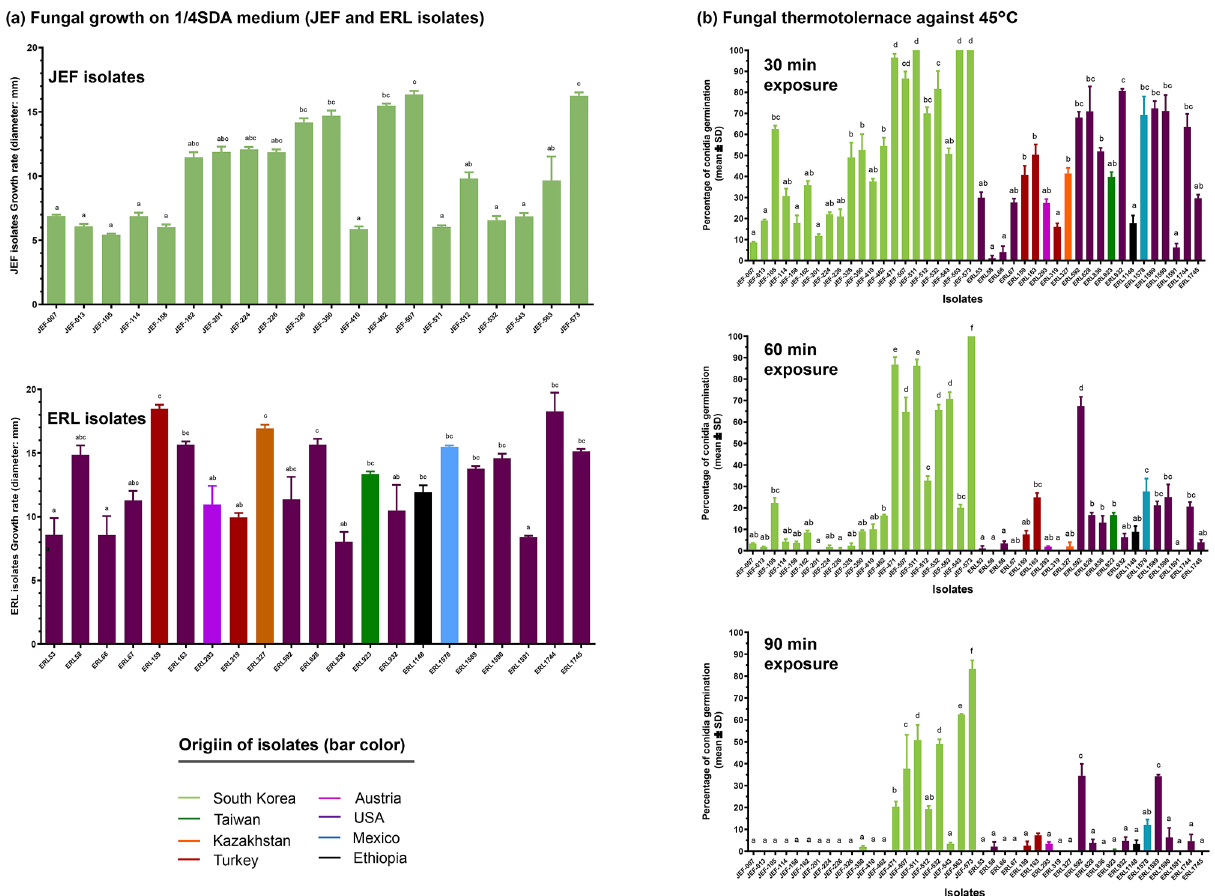
Figure 4. Fungal growth and thermotolerance. Fungal growth rate was represented as the diameter of colonies cultured on ¼ SDA medium at 25 °C for 7 days ( a ), and the thermotolerance was represented as conidial germination rate after 30, 60, and 90 min of heat exposure to 45 °C ( b ). In ( a ), growth rate of JEF and ERL isolates were represented separately to better visualize the graphs. In ( a ) and ( b ) graphs, small case letters denote statistical differences. The graphs were plotted using GraphPad Prism 5 (Inc., San Diego, CA,